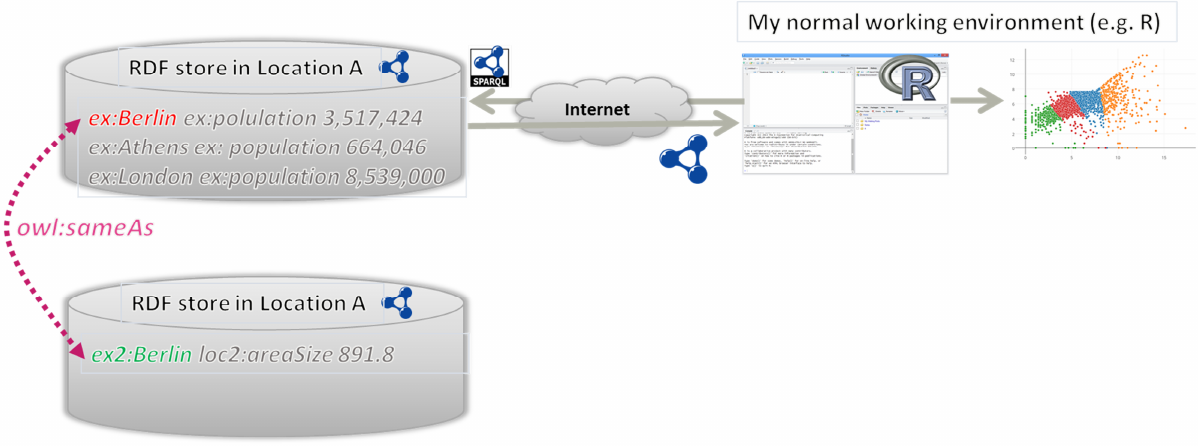
Figure 8: Accessing Multiple RDF Stores from within R Environment